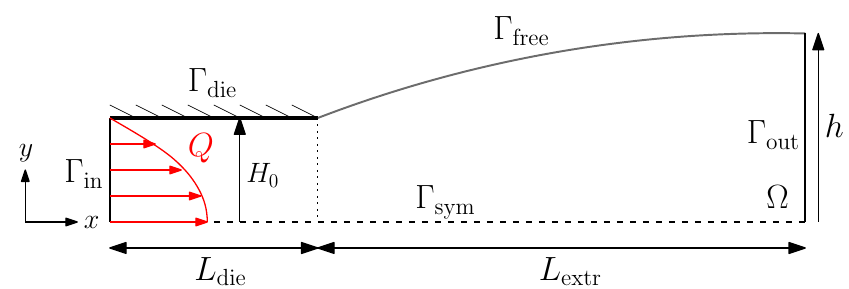
Figure 1. Schematic representation of the 2D planar extrudate swell problem. The free surface of the extrudate is indicated in gray.